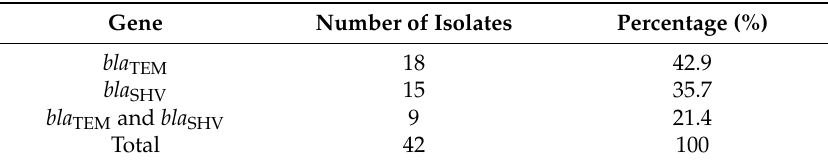
Table 2. bla TEM and bla SHV genes in bla CTX-M positive isolates. Gene Number of Isolates Percentage (%) bla TEM